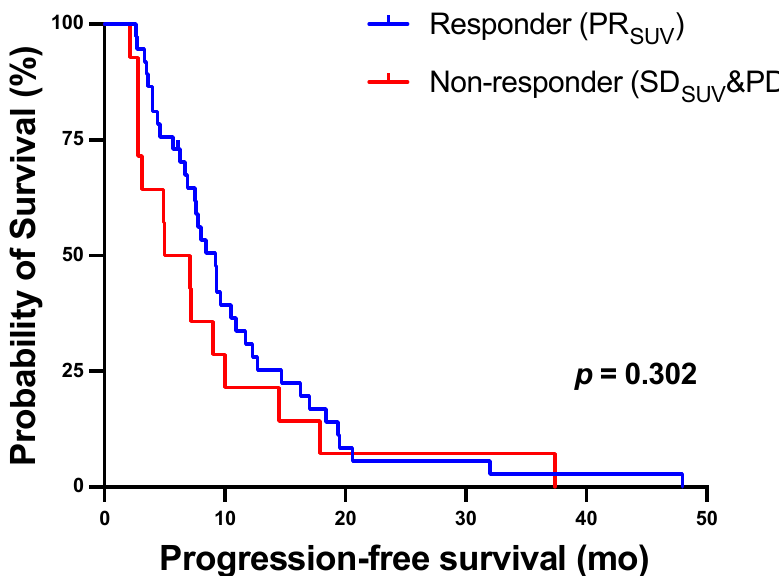
Figure 7. Kaplan–Meier curves for PFS stratified by molecular-imaging response assessment using SUV peak after two cycles of 177 Lu-PSMA-617 RLT.